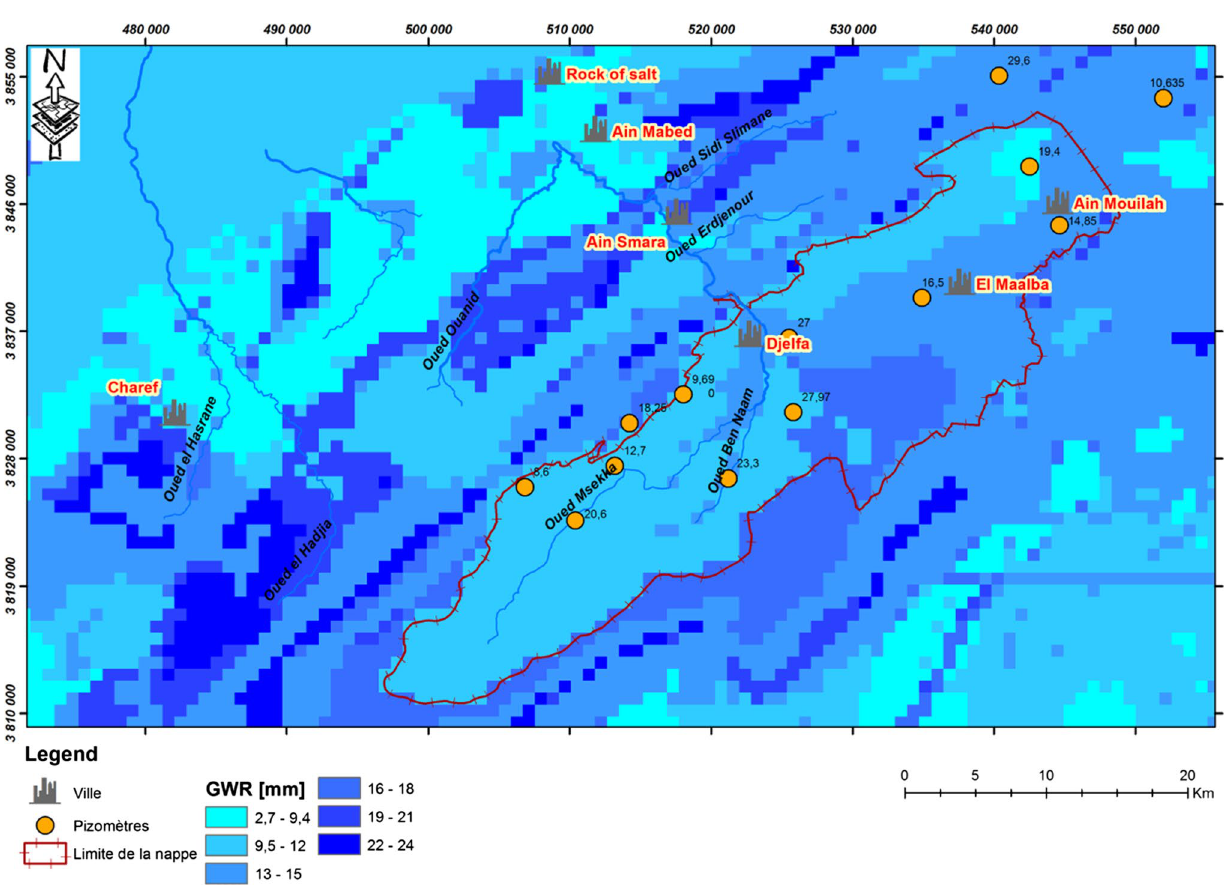
Fig. 8 Groundwater recharge